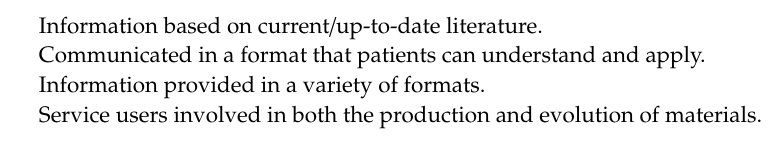
Table 1. Components in the Production of E ff ective Patient